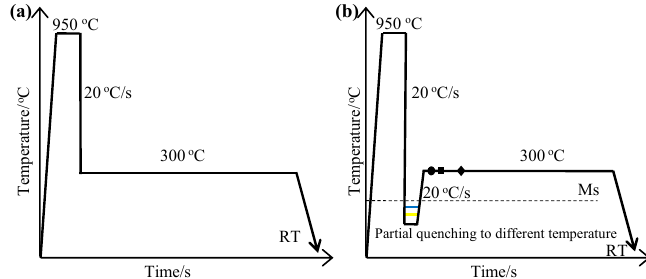
Figure 1. Schematic diagram of different heat treatments. ( a ) DIT process: direct isothermal bainite transformation. ( b ) QBT process: partial quenching to different temperature and subsequent isothermal bainite transformation; the circle, square, and diamond stand for the different isothermal holding time, respectively.